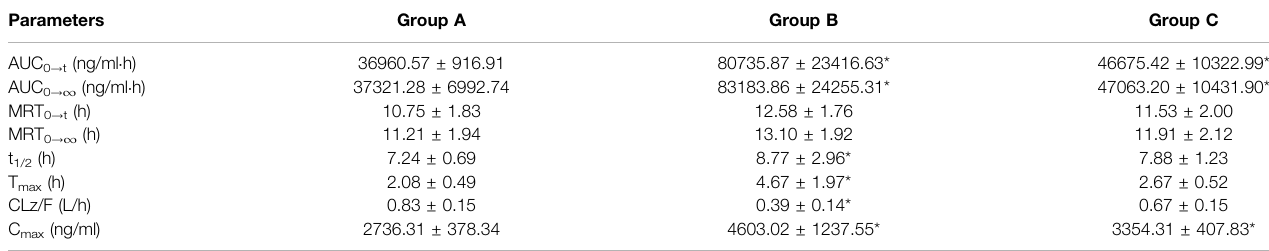
TABLE 4 | The main pharmacokinetic parameters of alpelisib in different treatment groups of rats: group A, the control group (0.5% CMC-Na); group B, a single-dose administration of ketoconazole (20 mg/kg); group C, a single dose administration of itraconazole (20 mg/kg). ( n (cid:1) 6, means ± SD). Parameters Group